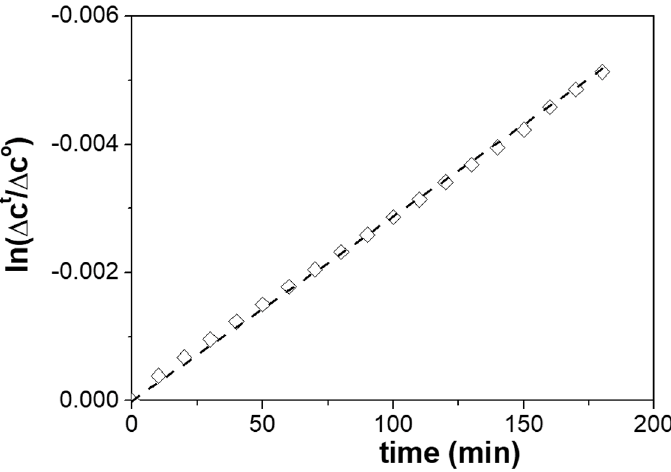
Figure 5. Time evolution of solution concentrations difference ratio at both sides of the 26% AlqCl/74% CTA PIM for NaCl donor concentration c do = 0.01 M. ∆ c t : solution concentration difference at time t; ∆ C o : initial solution concentration difference (t = 0).